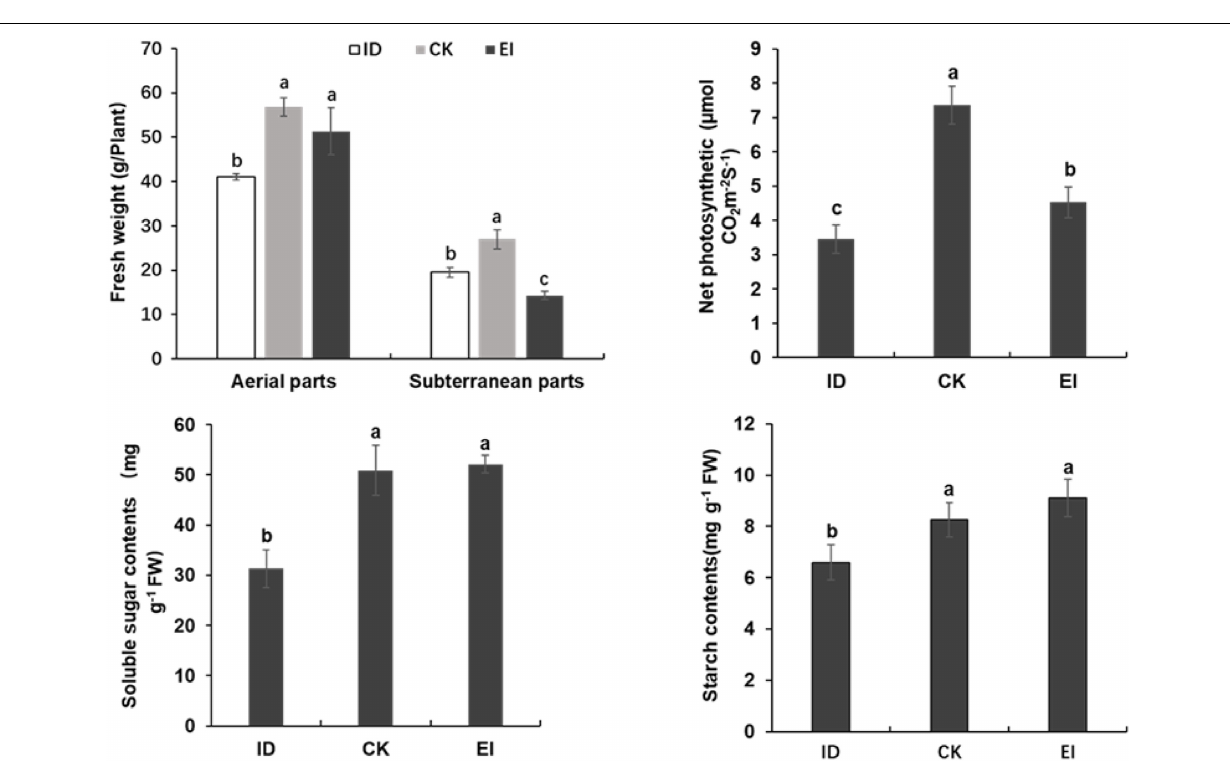
Frontiers in Plant Science |